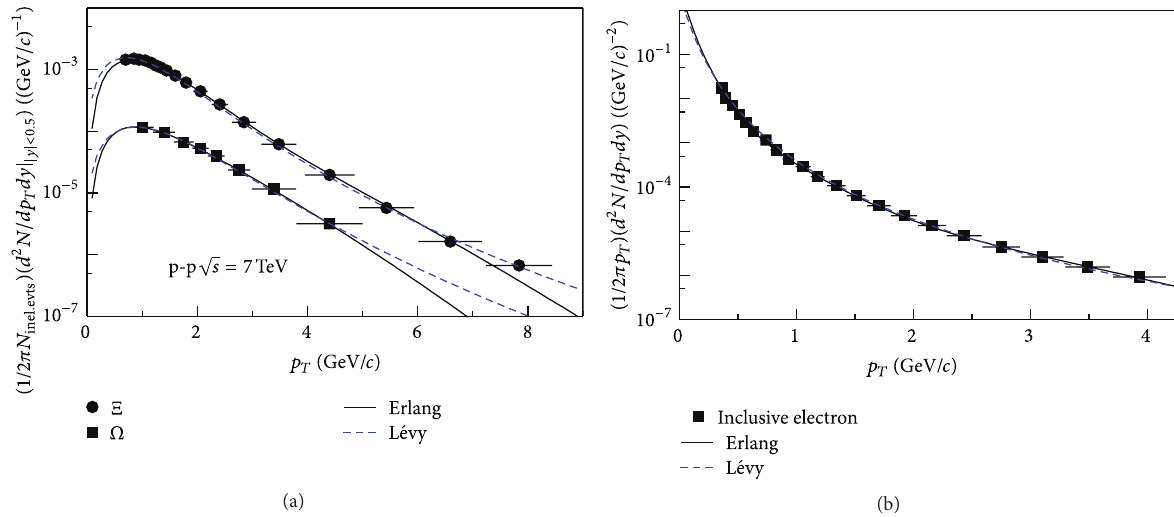
Figure 8: The 𝑝 𝑇 spectrums of (a) Ξ and Ω as well as (b) inclusive electrons produced in inelastic p-p collision at 7 TeV. Experimental data measured by the ALICE Collaboration [15, 18] are shown by the symbols. Results calculated by using the multicomponent Erlang distributions and the L´evy distributions are shown by the solid and dashed curves, respectively.